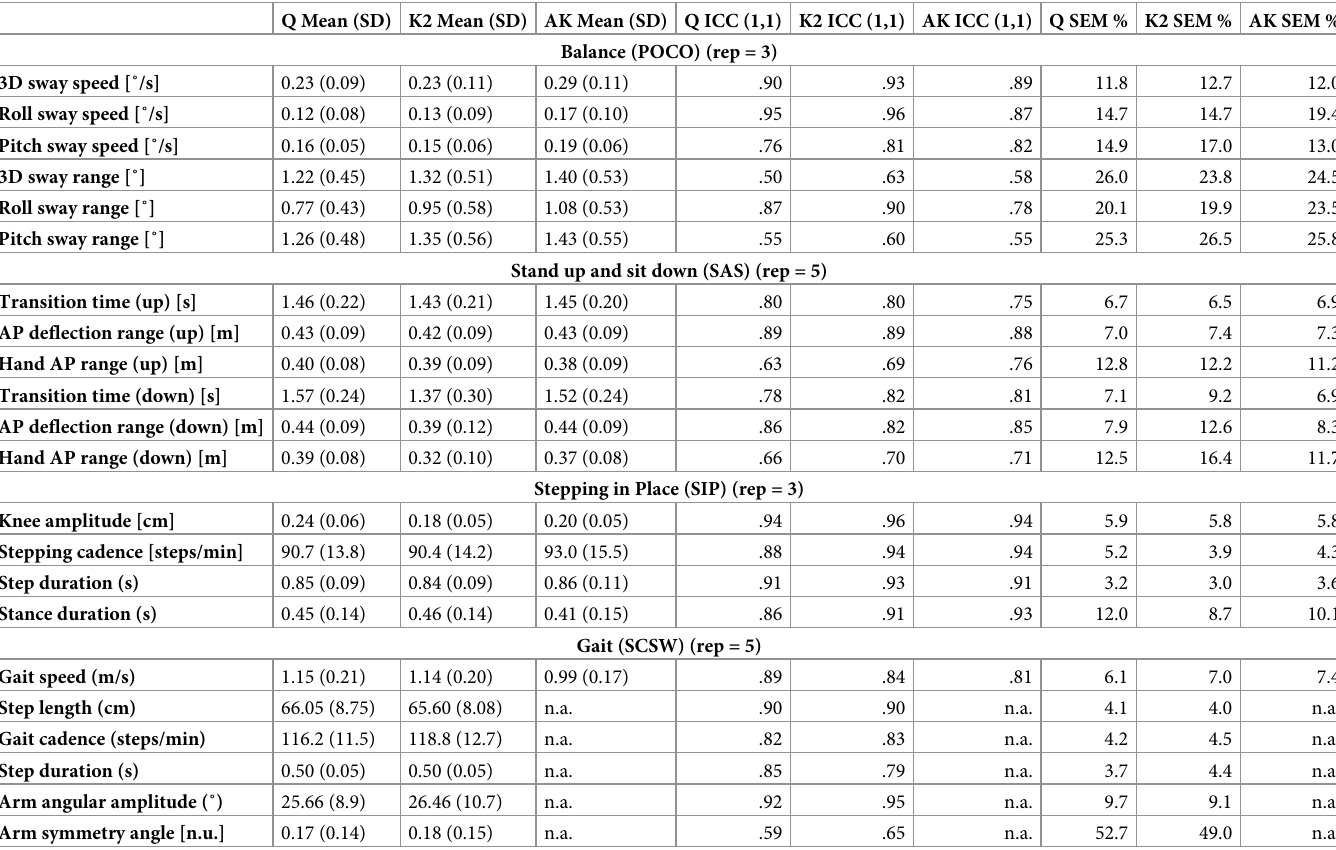
Table 6. Repeatability of spatiotemporal parameters derived from 3 to 5 repeated measurements as intra-class correlation coefficient ICC(1,1) and standard error of measurement (SEM